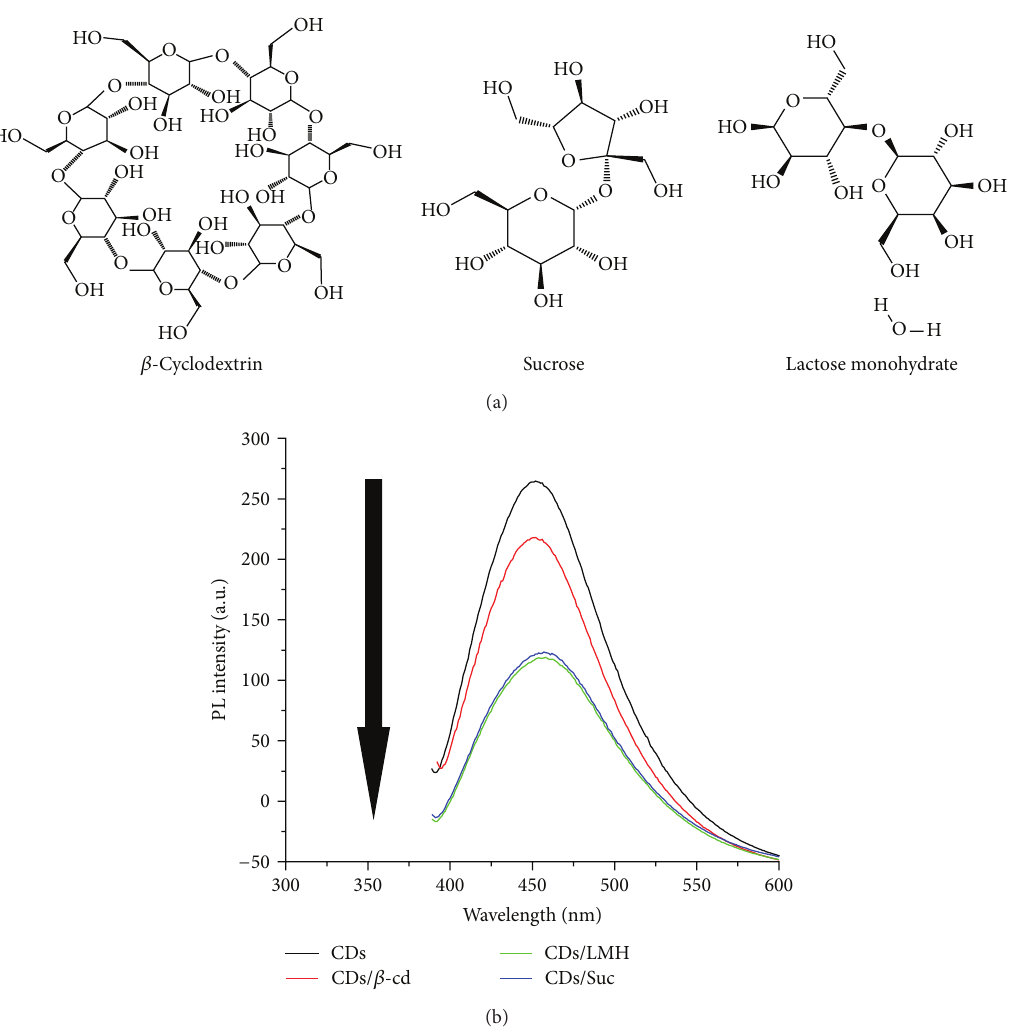
Figure 2: The photoluminescence (PL) spectra of CDs capped with 𝛽 -cyclodextrin ( 𝛽 -cd), lactose monohydrate (LMH) and sucrose (Suc), and excited at